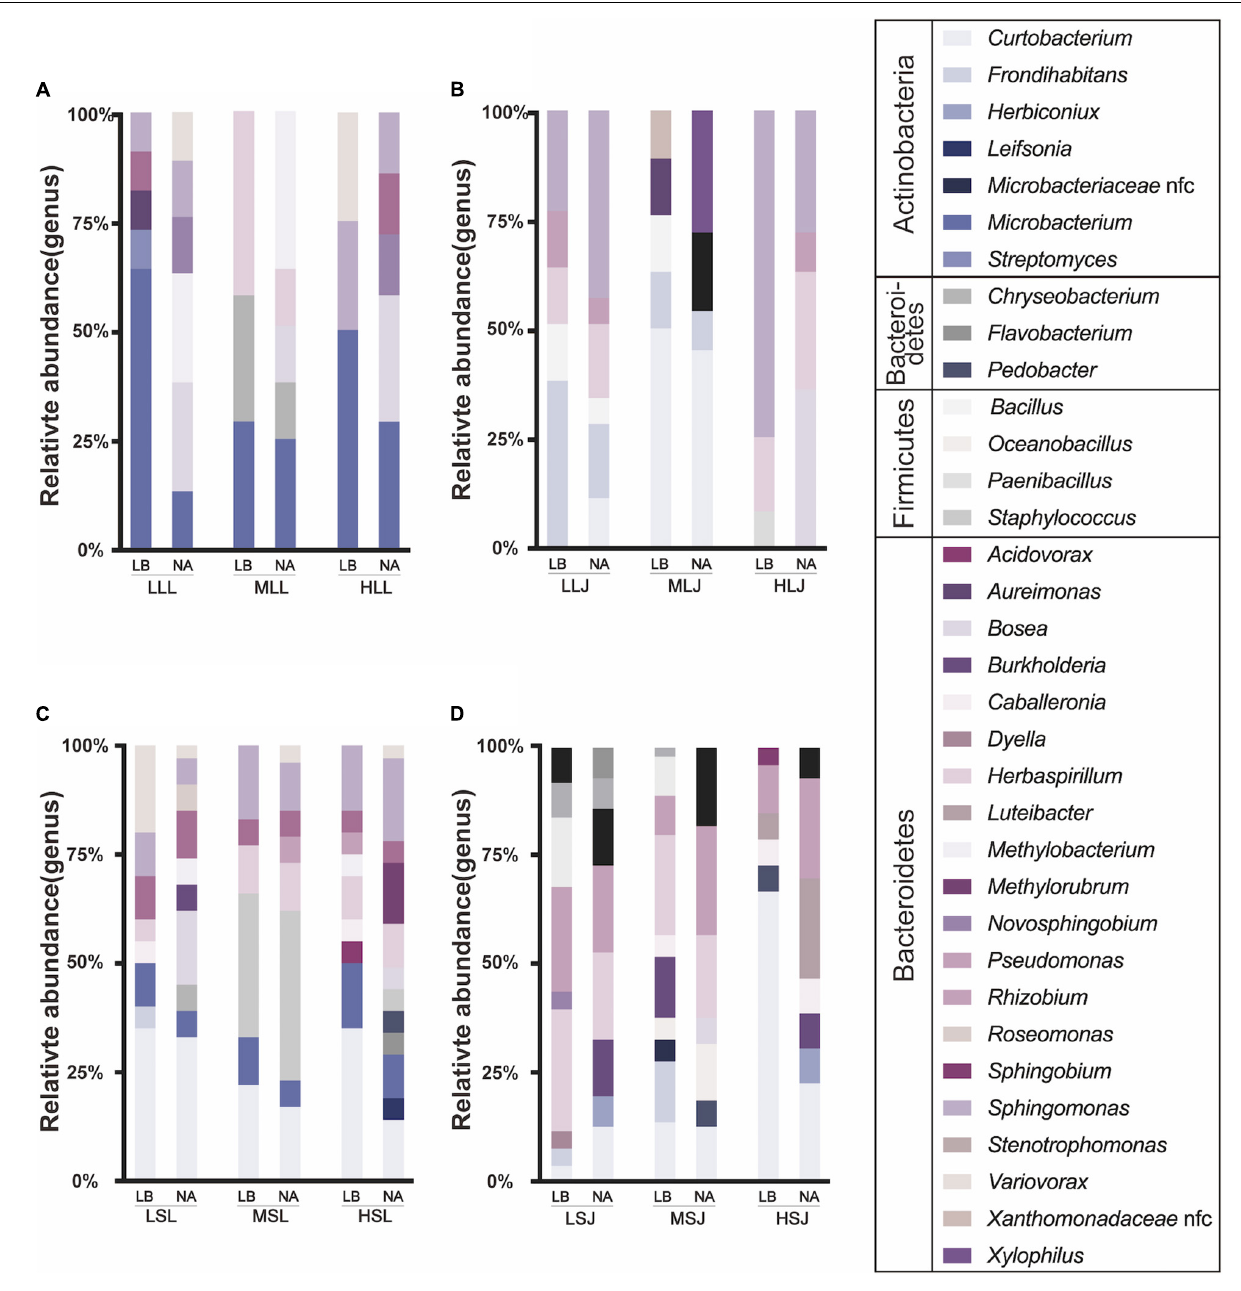
FIGURE 6 | Effects of sterilization treatments on the composition of cultured bacterial endophytes from tea plant leaves (A,B) and stems (C,D) in LB and NA medium. LLL, MLL, and HLL represent the leaf samples from the cultivar Longjing 43 treated with 0.5, 1.0, and 2.0% of NaClO. LLJ, MLJ, and HLJ represent the leaf samples from the cultivar Jiukeng treated with 0.5, 1.0, and 2.0% of NaClO. LSL, MSL, and HSL represent the stem samples from the cultivar Longjing 43 treated with 0.5, 1.0, and 2.0% NaClO. LSJ, MSJ, and HSJ represent the leaf samples from the cultivar Jiukeng treated with 0.5, 1.0, and 2.0%